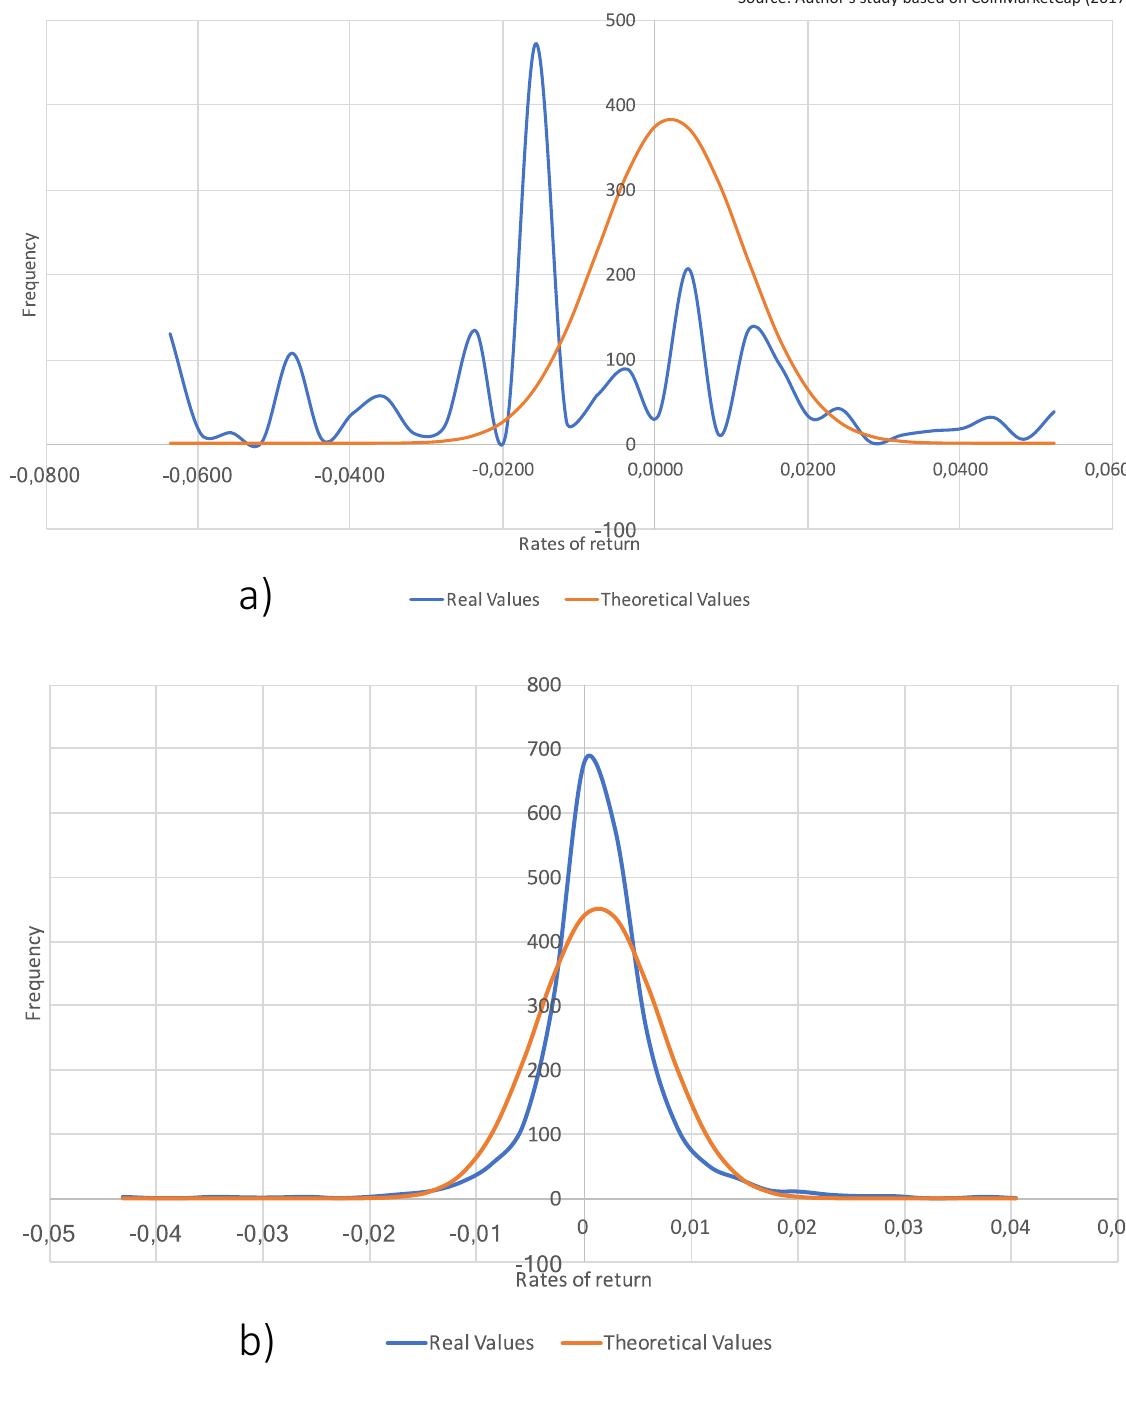
Figure 7. Histogram of daily rates of return for USD (a) and EUR (b), respectively (2,275 observations in the period